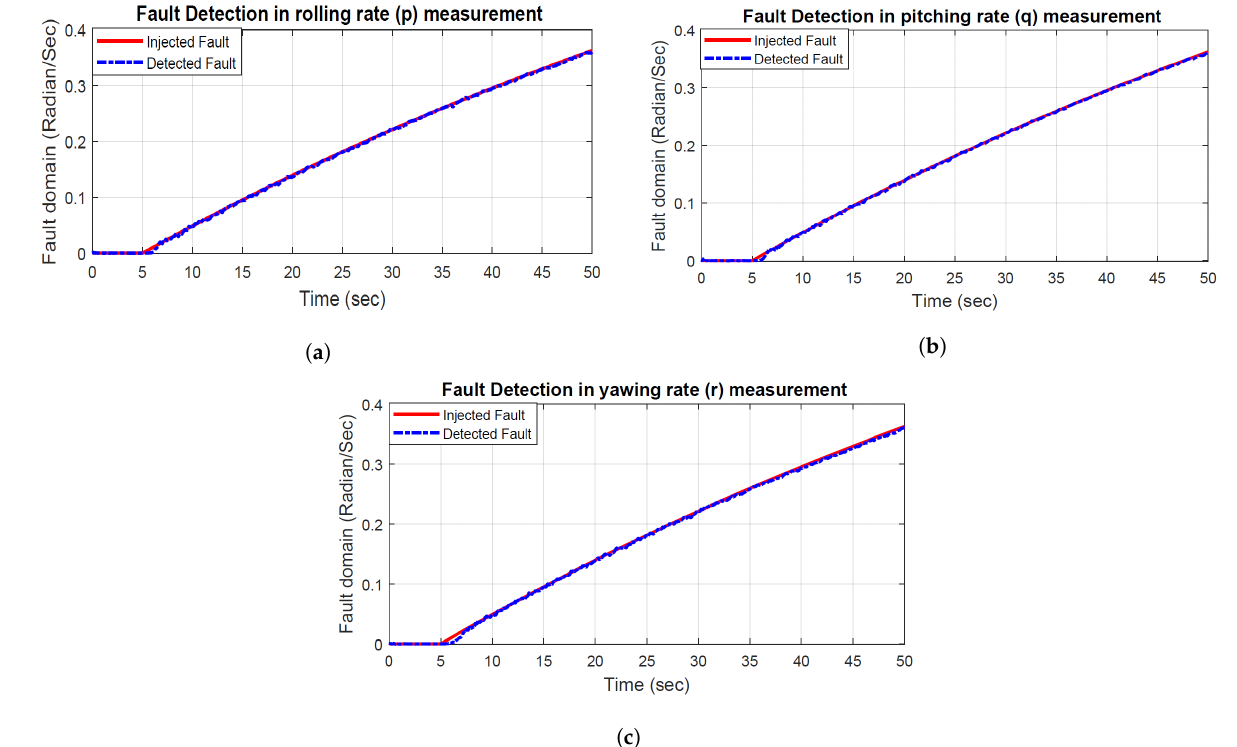
Figure 5. Incipient fault detection. ( a ) Incipient fault detection in rolling rate measurement. ( b ) Incipient fault detection in pitching rate measurement. ( c ) Incipient fault detection in yawing rate